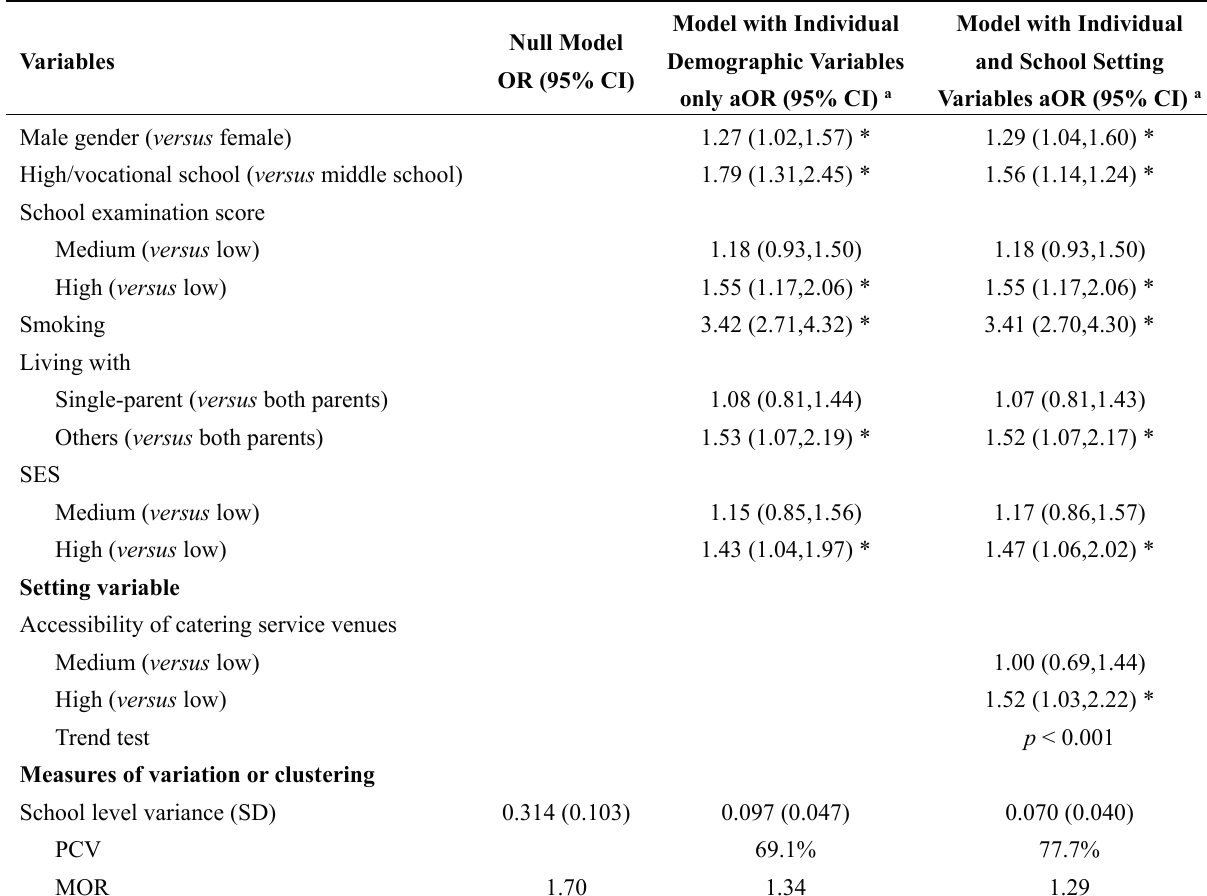
Table 2. Predictors of past 30 days alcohol use among 2223 adolescents in